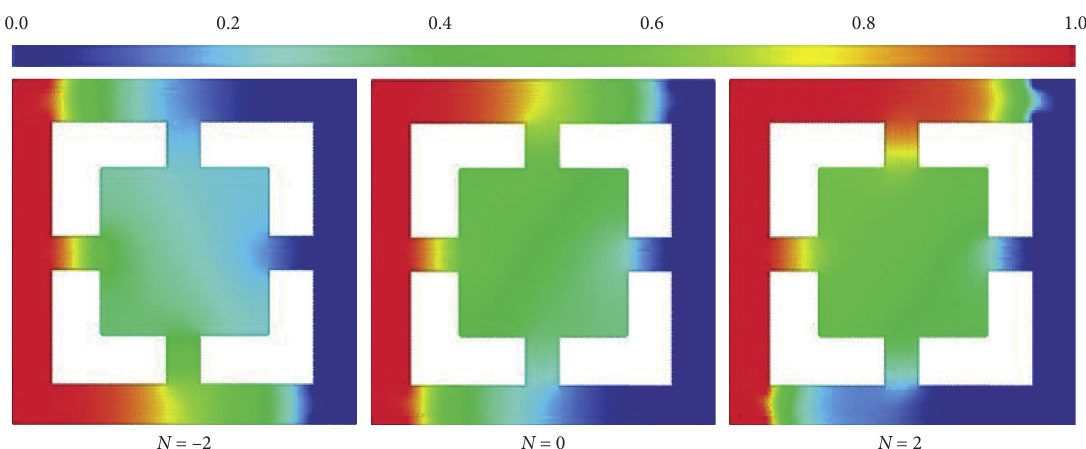
Figure 3: Features of temperature below the variations of a buoyancy ratio parameter at Ra � 10 4 , ϕ � 0 . 01 , Da � 10 − 3 , η ε � 0 . 6 , Le � 20, and τ �